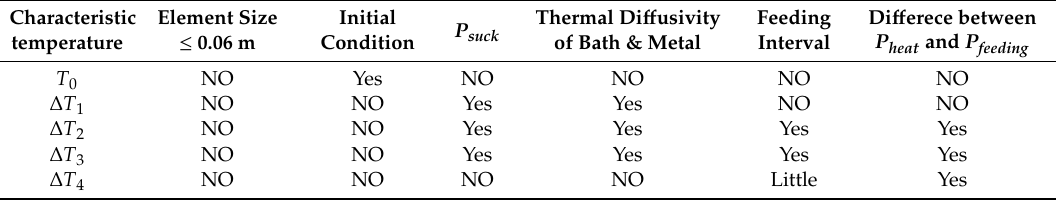
Table 4. Whether characteristic temperatures are sensitive to several